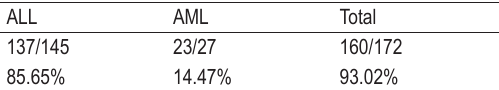
TABLE 4. Children sick with ALL and AML based on the gen-